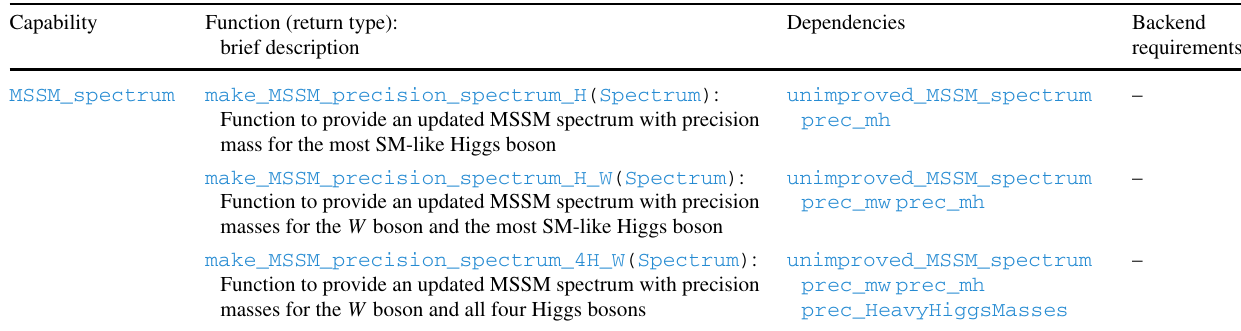
Table 2 New or modified module functions of note in PrecisionBit 1.1 . Precision spectra can now be computed using precision values for 1) the W mass only (as in PrecisionBit 1.0 ; not shown), 2) the SM-like Higgs mass only, 3) the W mass and the SM-like Higgs, or 4) the W